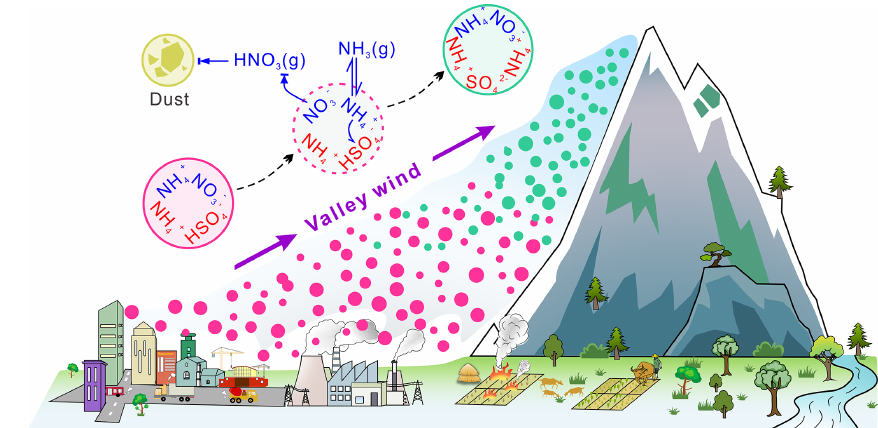
Figure 8. Schematic of the physicochemical behaviors of nitrate and ammonium during the transport process.